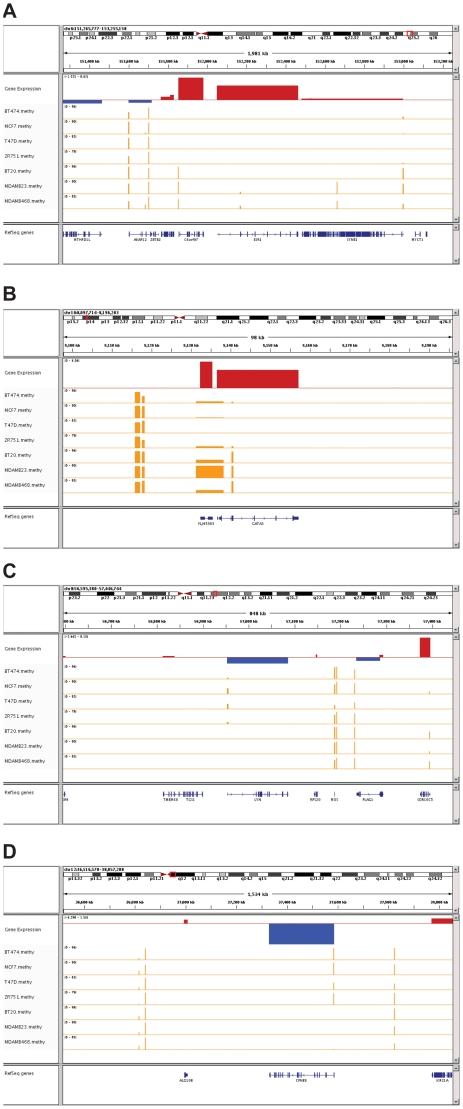
Representative examples of methylation status and mRNA abundance for genes that are differentially methylated in cell lines and differentially expressed in both cell lines and tumors.
Panel A: C6orf97 (with SYNE1 and ESR1); Panel B: GATA3; Panel C: LYN; and Panel D: CPNE8. On each figure, gene expression track represents the log2 fold change of gene expression between ER+ and ER− cell lines, red for up-regulation and blue for down-regulation in ER+ cell lines. Below that track is the methylation data for each cell line, which shows the average percent of methylated CpGs (dynamic range 0–100%) in the CpG Islands that were interrogated in this analysis.